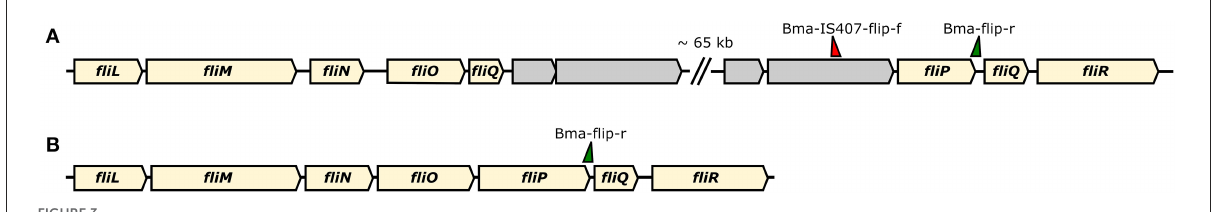
FIGURE3 Schematic representation of the gene cassette for flagellum formation in B. mallei (A) and B. pseudomallei (B) . In B. mallei the fliP gene is disrupted by an IS407A element (gray arrows) that further promoted recombination, thus disrupting the cassette. Primer binding sites for differentiation of the two species according to the assay developed by Scholz et al. (21) are indicated by green/ red